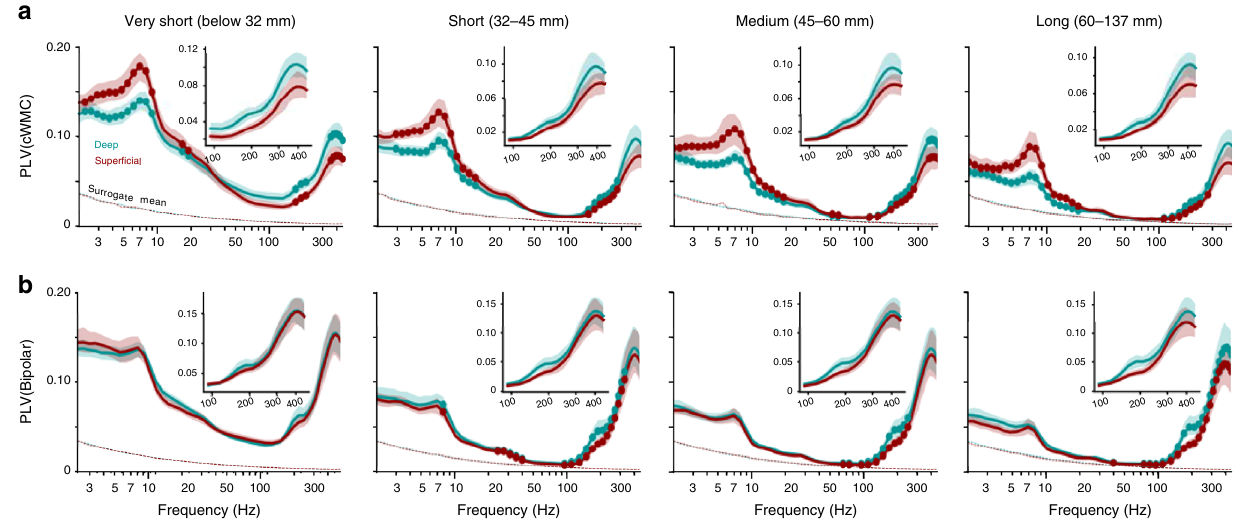
Fig. 5 HFO synchrony has a laminar pro fi le opposite to that of low-frequency synchrony. a PLV spectra for contact pairs located in deep ( − 0.3 < GMPI ≤ 0; teal) and super fi cial cortical layers (0.5 < GMPI < 1; red) with cWM and b bipolar reference (GMPI indicates the normalized depth of the electrode contact in gray matter so that GMPI = 0: white/gray-matter surface and GMPI = 1: pial surface, see Supplementary Fig. 2). The markers indicate signi fi cant differences (two-tailed permutation test, N permutations = 100: p < 0.05, Benjamini – Hochberg method at α < 0.05). Inset: mean PLV in HGA frequencies. Dashed lines indicate the 99.9th%-ile of the surrogate data ( N randomizations = 100). Shaded areas indicate the 2.5 – 97.5%-ile bootstrap con fi dence-limits of the mean PLV ( N bootstraps = 100).